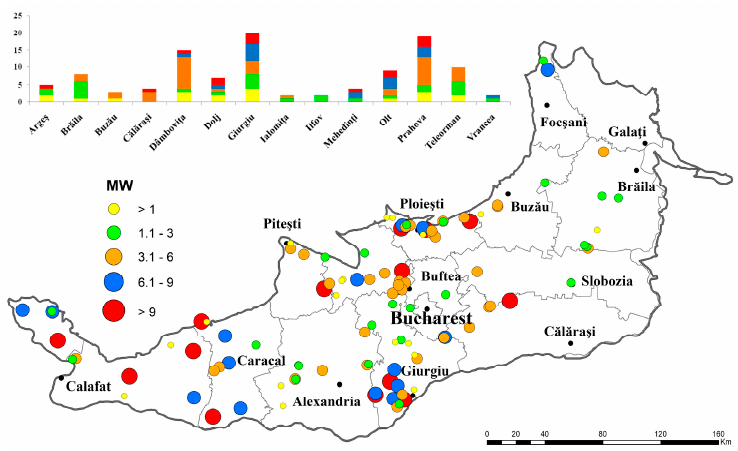
Figure 5. The installed power of PV farms.